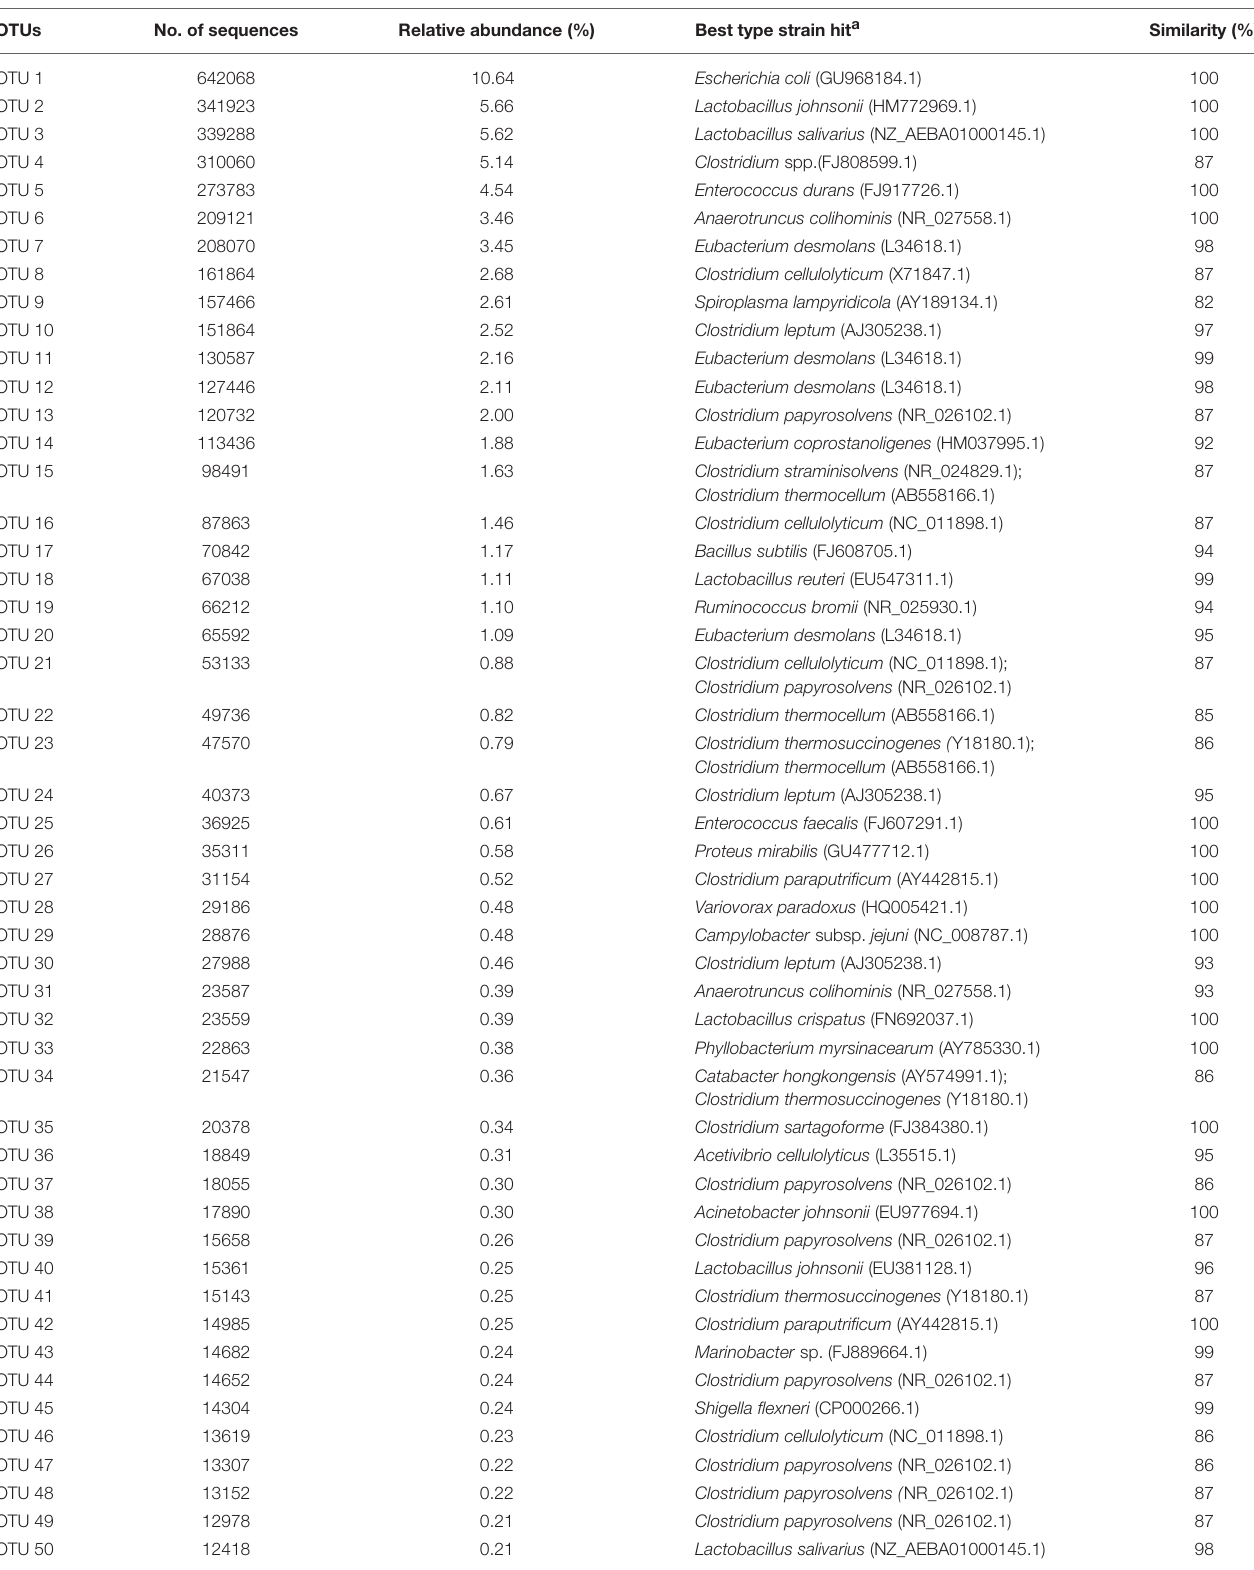
TABLE 1 | The 50 most abundant OTUs retrieved from different gut sites from all birds independent of the infection status. OTUs No. of